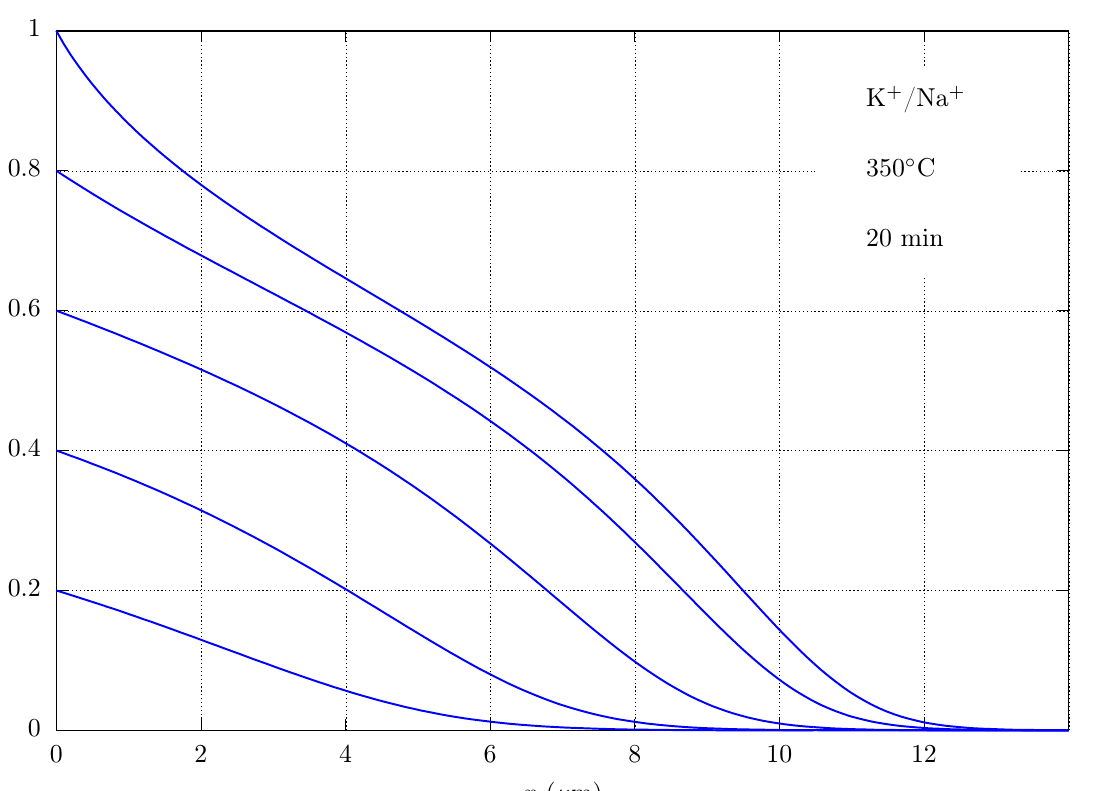
= 0.2, 0.4, 0.6, 0.8 and 1. The interdiffusion coefficient S